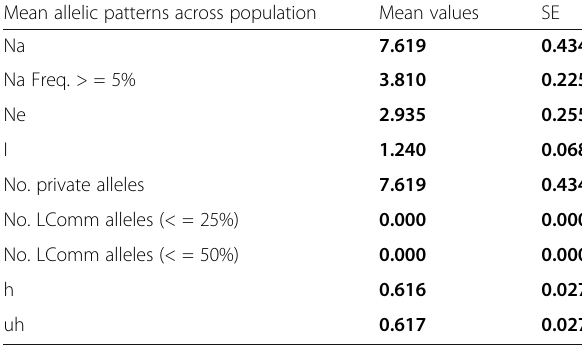
Table 3 Mean allelic patterns across population using PowerPlex® Y23 System Mean allelic patterns across